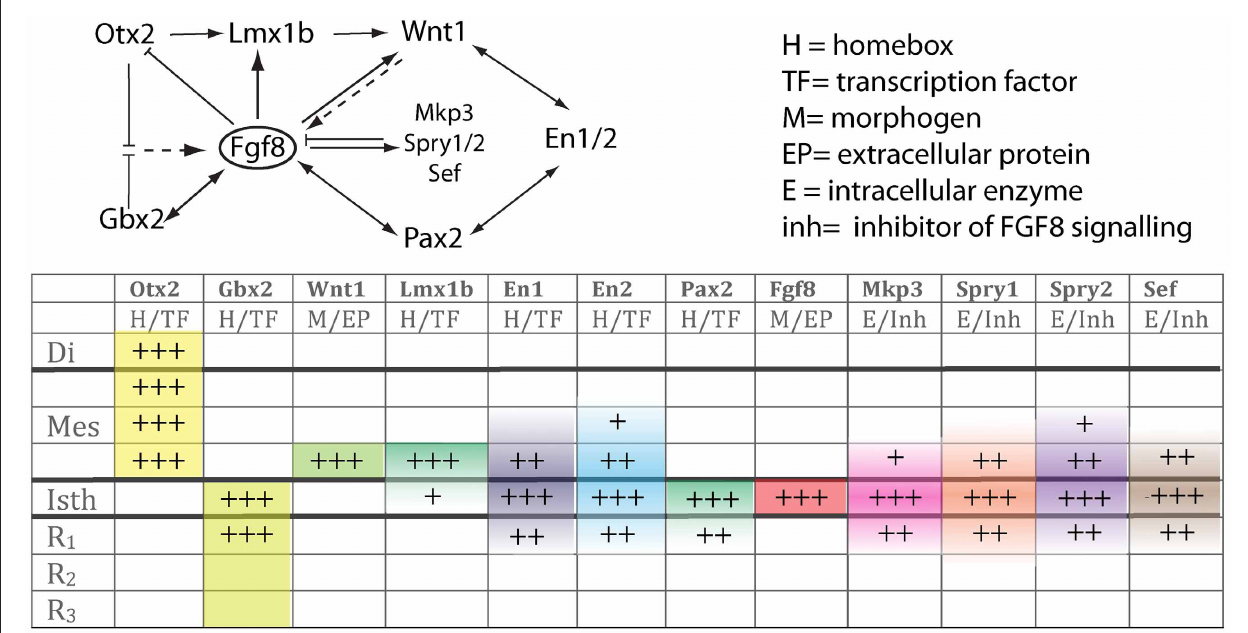
summarizes the expression intensity and range of genes along the AP axis of the neural tube focusing on the isthmus. The color code depicts their mRNA expression range from the isthmus toward rostral or caudal